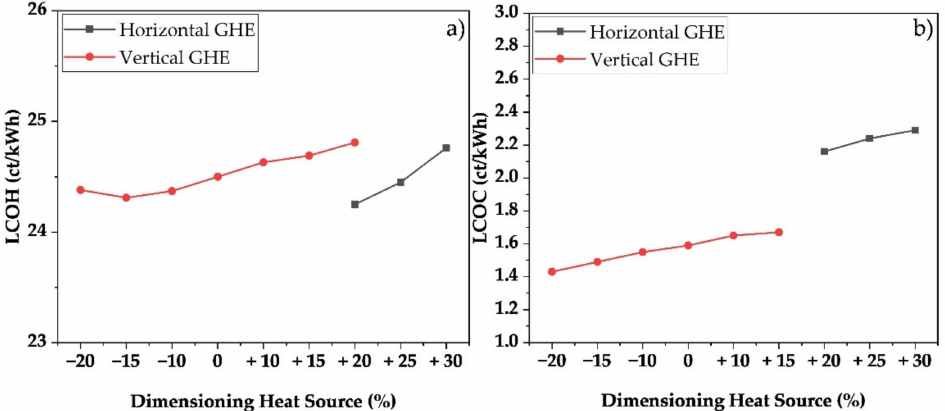
Figure 11. LCOH ( a ) and LCOC ( b ) for various dimensioning of the geothermal heat source for the region of Bordeaux.